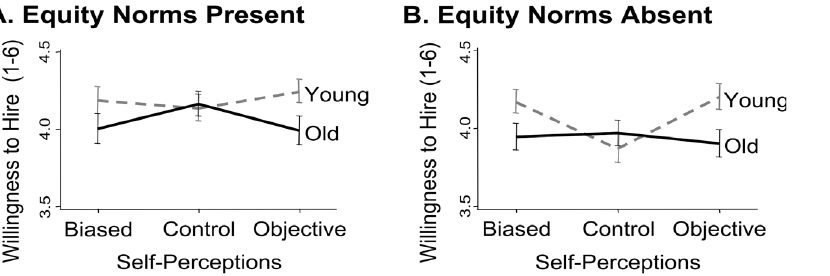
Figure 1. Mean differences in hiring decisions are represented as a function of whether the job applicant was young or old and of the self-perceptions experimental manipulation (biased, objective, or control), when equity norms were present (Panel A) or absent (Panel B). Error bars represent the standard errors.